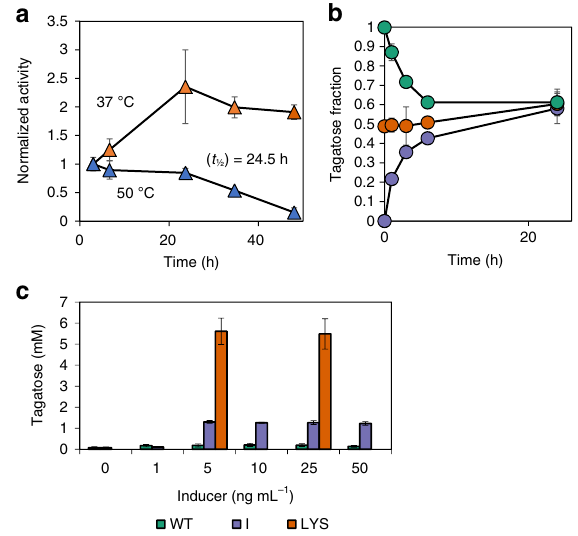
Fig. 3 Encapsulation of LsLAI improves equilibrium conversion and provides thermal stability. a Loss of activity of encapsulated LsLAI (IC2) over time incubated in PBSM pH 7.4 at 37 °C (orange) or 50 °C (blue). Half-life calculated assuming fi rst-order decay. b Equilibrium conversion of encapsulated LsLAI starting from 30 mM total substrate: 1:0 (30 mM galactose, purple), 1:1 (15 mM each, orange), or 0:1 (30 mM tagatose, green) galactose:tagatose, respectively. c Tagatose production from 200 mM galactose of L. plantarum wild type (WT) cells (green), IC2 cells expressing LsLAI intracellularly (I, purple), or crude lysate of the same IC2 cells expressing LsLAI cytoplasmically (LYS,orange) at different induction concentrations. The data are means from three biological replicates.